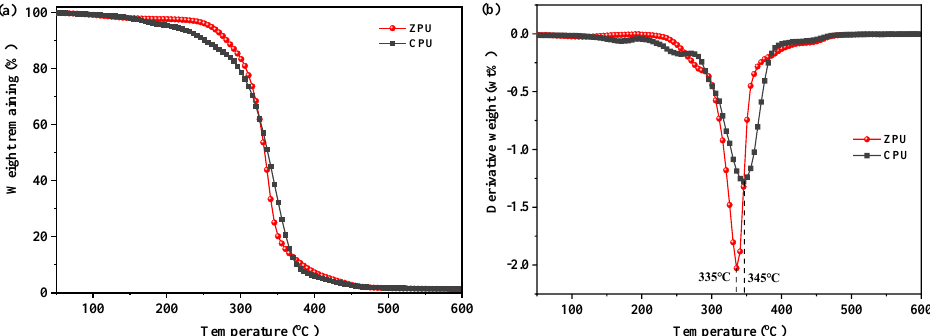
Figure 4. Thermal property of ZPU and CPU: ( a ) TGA; ( b ) DTG.